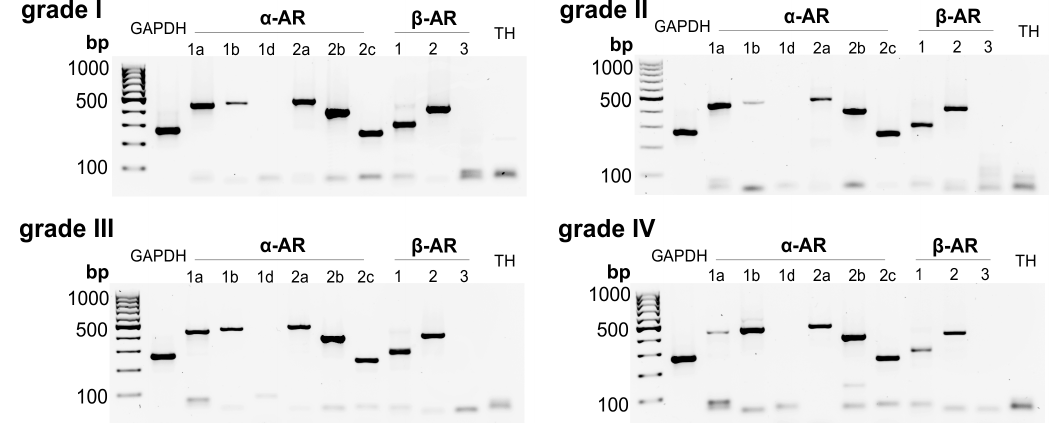
Figure 1. Adrenoceptor (AR) and tyrosine hydroxylase (TH) gene expression in human intervertebral disc (IVD) tissue analyzed by RT-PCR. Gene expression of all known AR subtypes as well as of TH in human IVD tissue samples with different degree of degeneration (representative pictures of human IVD samples; 4-grade classification scale: Non-/moderately (grade I), moderately (grade II), significantly (grade III), and massively degenerated (grade IV) ( n = 43)). Table 1. AR gene expression distribution in human IVD tissues with different degrees of degeneration ( n = 43).